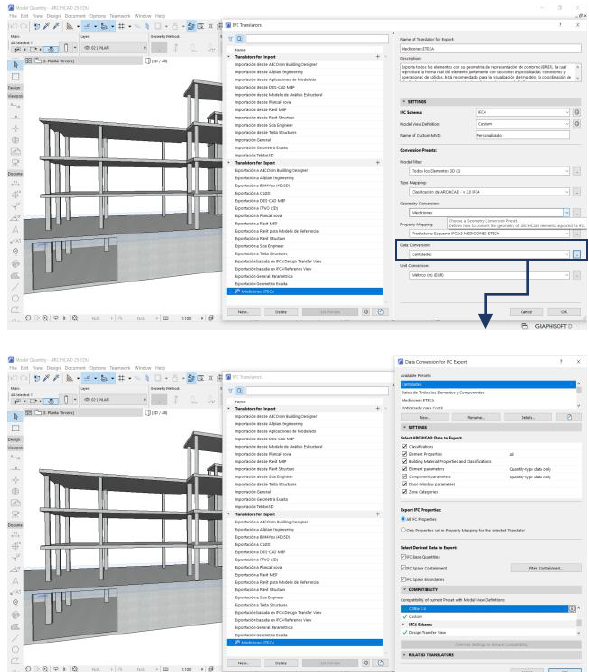
Figure 7. Preparation of the IFC Translator, specific to export quantities: a. Geometry Conversion; b. Data